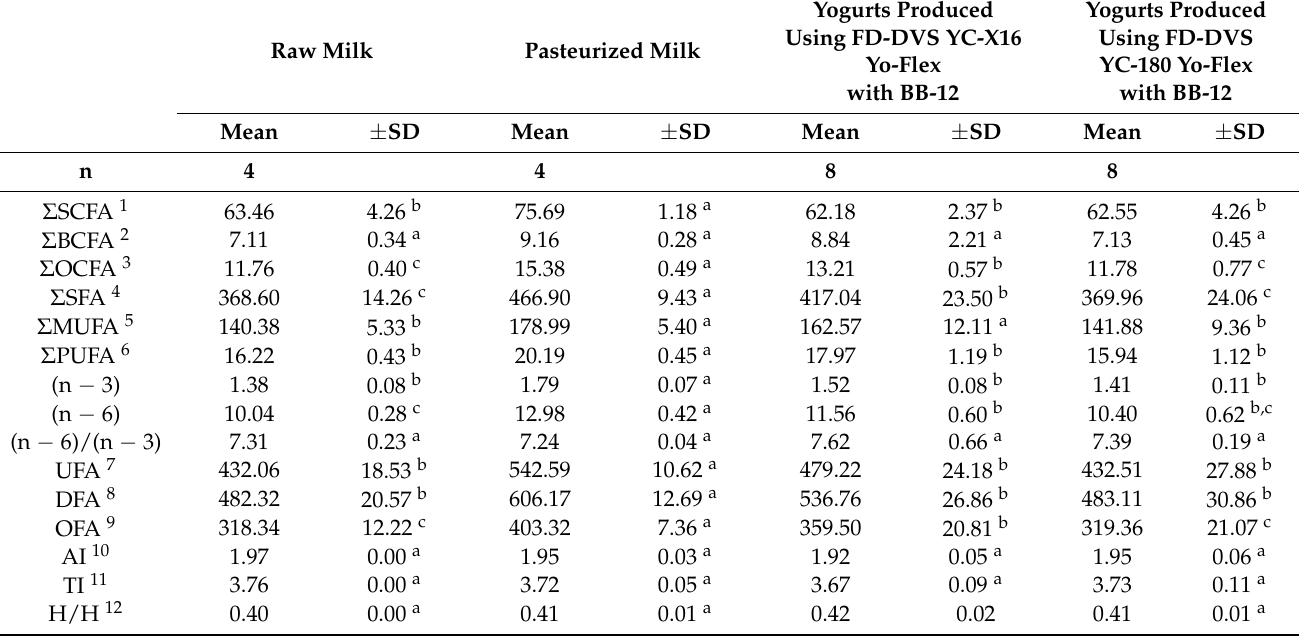
Table 1. The sum of fatty acids (mg/g fat) and nutritional indices of milk and yogurts produced.